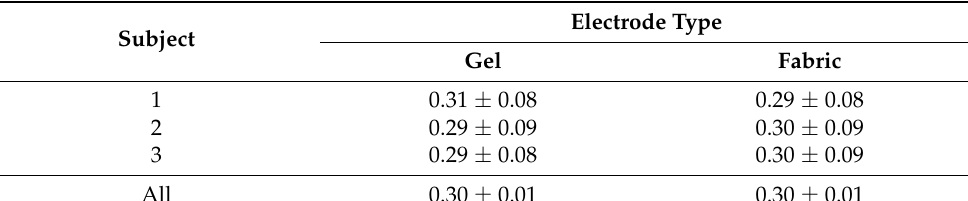
Table 3. The mean and standard deviation of throughput (TP) for each experimental subject and overall during the usability test.